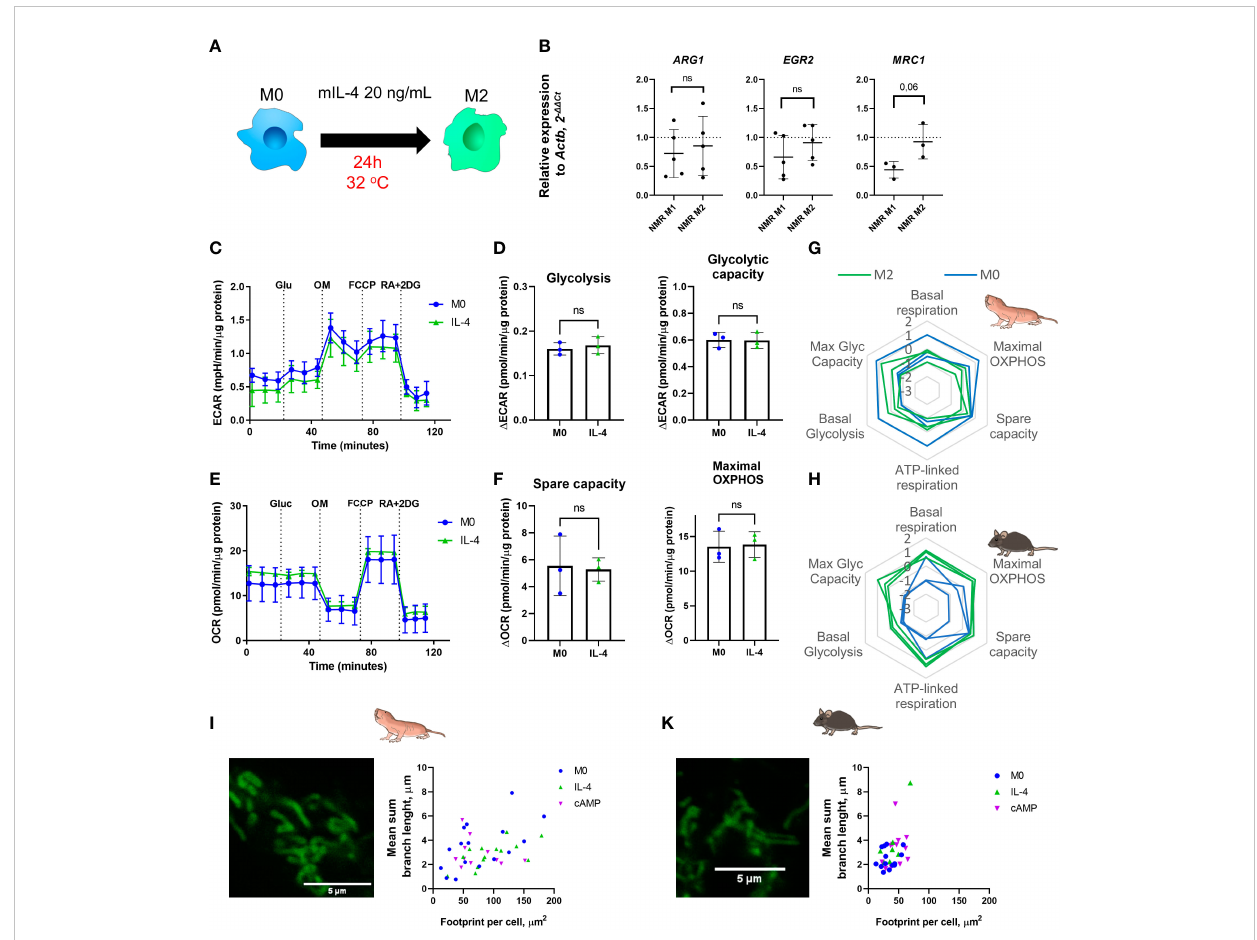
FIGURE 5 Recombinant mouse IL-4 triggers non-canonical M2 polarization pro fi le in naked mole-rat BMDM cultures. (A) To induce M2 polarization NMR BMDM were incubated with mouse recombinant IL-4 (20 ng/mL) for 24h, then cells were subjected to metabolic stress test or collected for RNA extraction, control mouse BMDM were tested in parallel; (B) Relative expression of M2-associated genes in M1 and M2-conditioned NMR BMDM as a fold change to the expression level observed in M0; (C) Representative diagram of the real-time changes in extracellular acidi fi cation (ECAR) of M0 and M1 NMR macrophages and cellular glycolysis parameters (D) . Representative diagram of the real-time changes in OCR of M0 (blue) and M2 (green) NMR macrophages under combined stress test (E) and parameters of cellular respiration parameters (F) ; (G) Summary of metabolic pro fi les of NMR and murine (H) M0 (blue) and M2 (green) macrophages represented as z-score transformed mean for six metabolic parameters on radar chart, each line on a diagram represents an independent metabolic stress experiment. (I) Representative image of MitoTracker Green stained mitochondria of NMR and murine (J) M2 macrophages and their structural parameters. Results displayed as mean ± SD; ns-not signi fi cant, Student ’ s paired t-test or Mann-Whitney